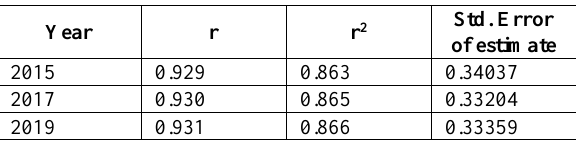
Table 1. Results of the regression analysis models in 2015, 2017, and 2019.